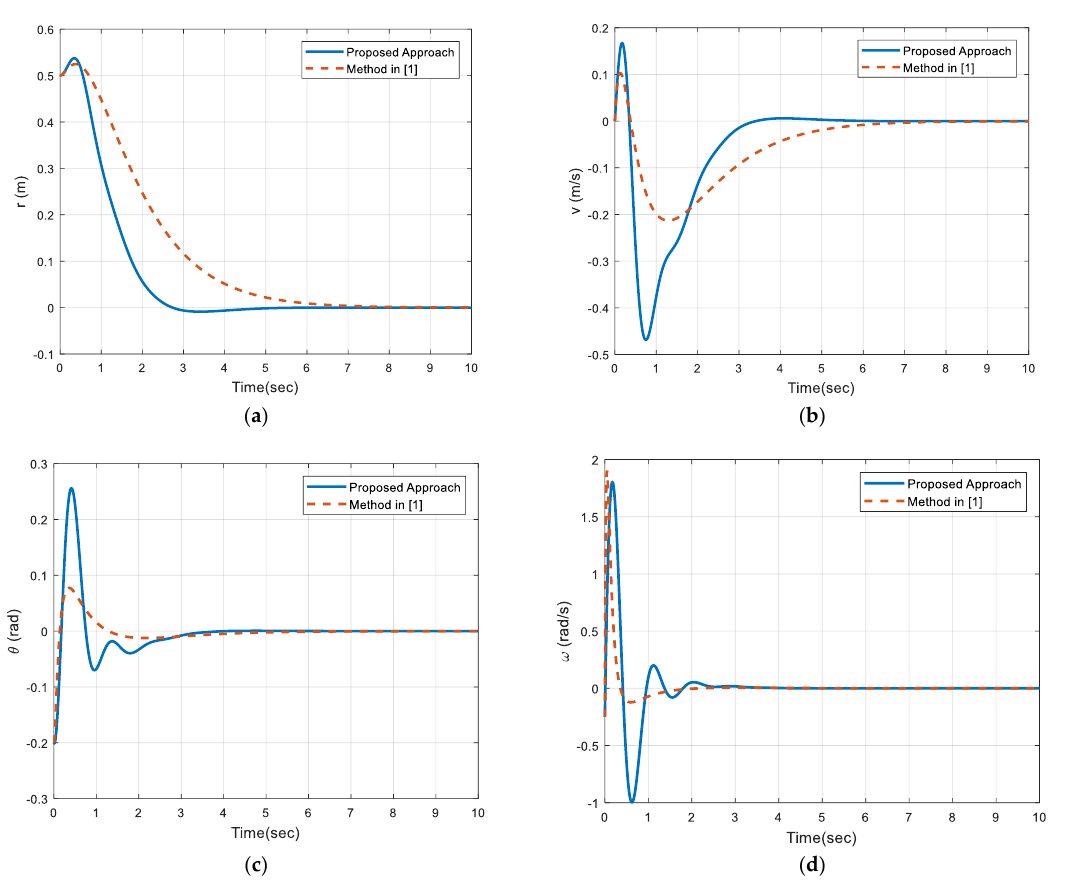
Figure 3. ( a ) State x 1 trajectoriy of a nominal nonlinear system (indicating the suggested approach’s stabilizing efficiency in comparison to the method applied in [1]) . ( b ) State x 2 trajectoriy of a nominal nonlinear system (indicating the suggested approach’s stabilizing efficiency in comparison to the method applied in [1]) . ( c ) State x 3 trajectory of a nominal nonlinear system (indicating the suggested approach’s stabilizing efficiency in comparison to the method applied in [1]). ( d ) State x 4